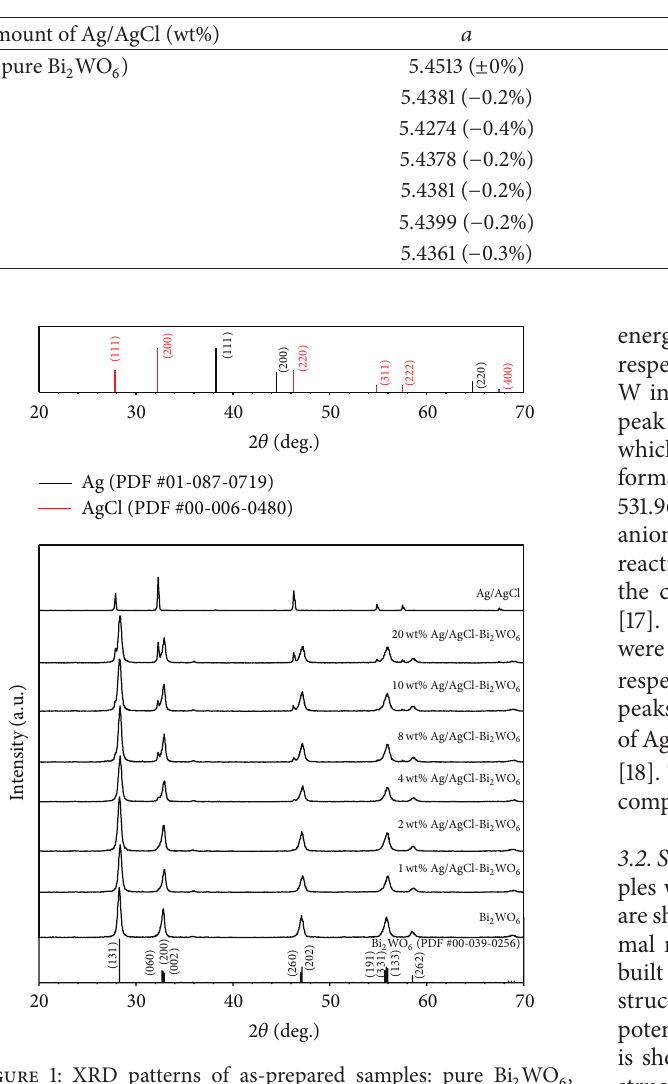
Table 1: Lattice parameters of Bi 2 WO 6 and Ag/AgCl-Bi 2 WO 6 composites.